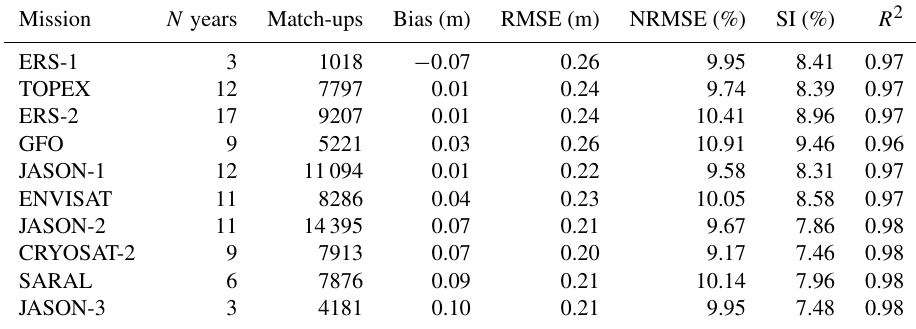
Table 4. Statistical metrics for the validation of denoised SWH in the Sea State CCI dataset v1 against in situ data located > 200km offshore.